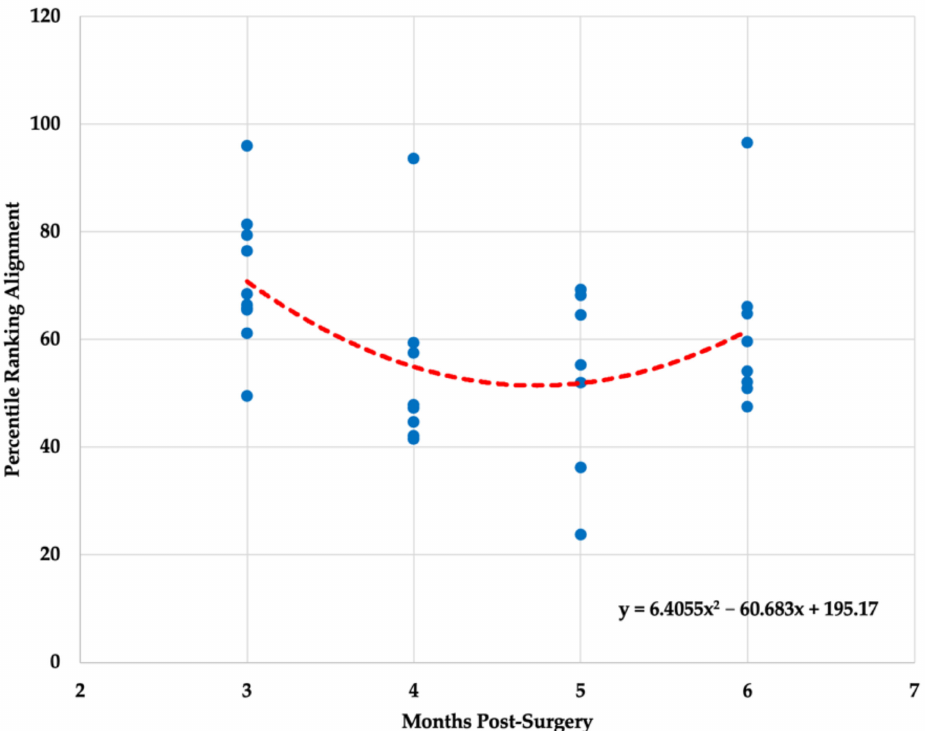
Figure 2. Polynomial regression model for alignment variable.